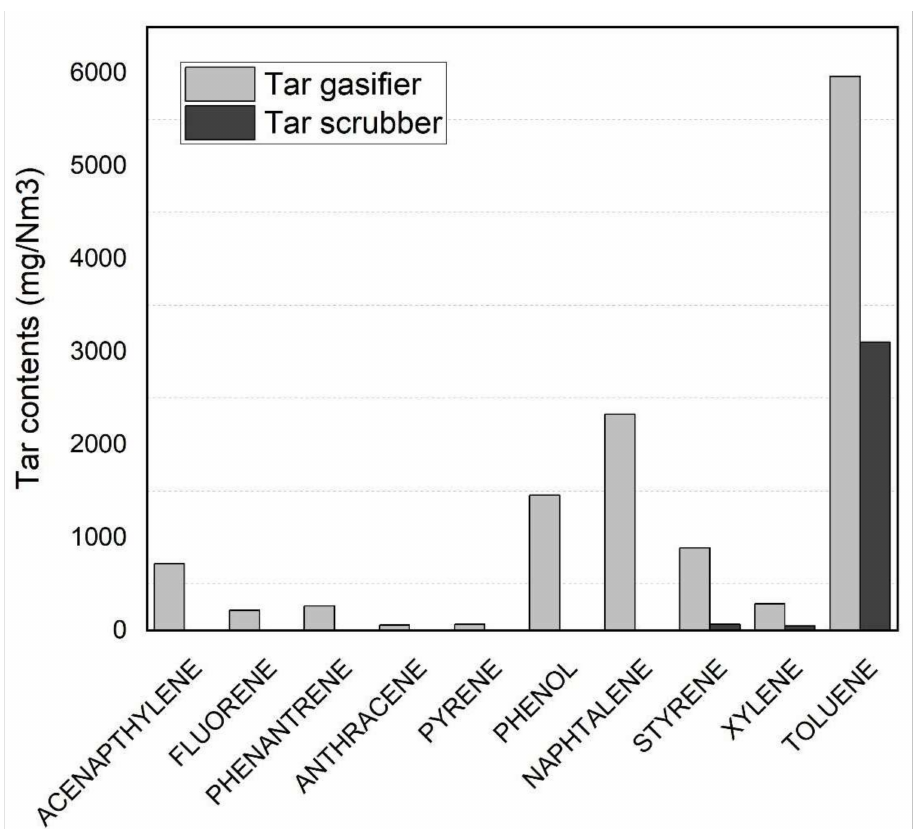
Figure 7. Tar contents measured in the raw syngas and downstream from the water